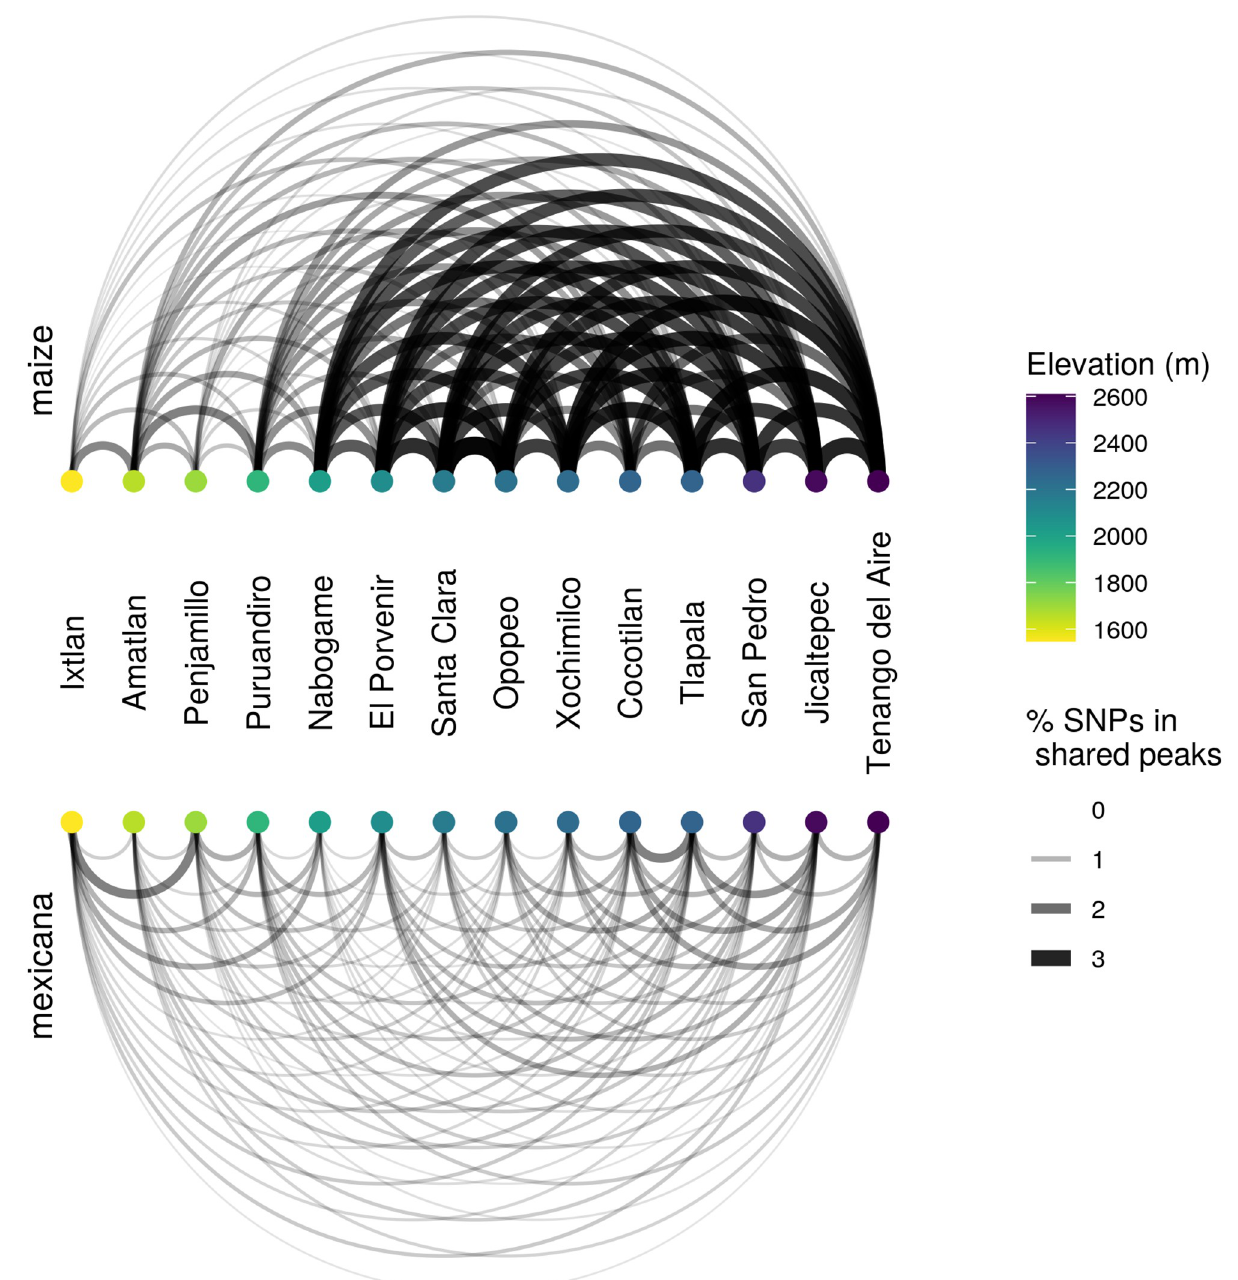
Fig 6. Introgression peaks shared across populations. Networks for sympatric maize (top) and mexicana (bottom), where each node is a sampled population labelled by location and ordered by elevation. Edges connecting a pair of populations represent the percent of SNPs within shared ancestry peaks (introgressed ancestry > 2 s.d. above each population’s mean ancestry). Sharing between all pairs of populations exceeds expectations based on multivariate-normal simulations that model genomewide covariance in ancestry. The relatively darker thicker lines connecting the high elevation maize populations (except for Cocotilan), indicate that these populations share high introgression peaks at especially high frequencies.